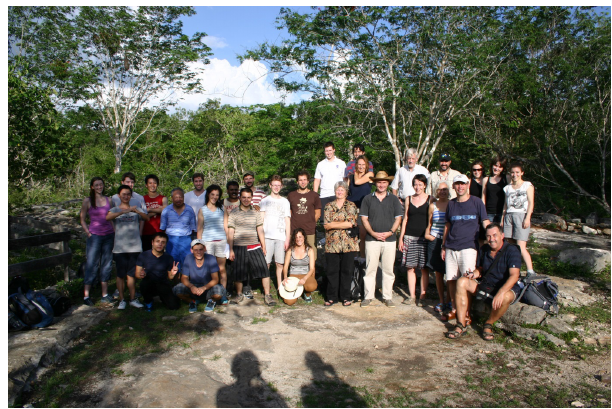
Figure 1. Participants of the first IAGA School, held in Merida, Mexico, in 2013, during the trip to inland Yucatan